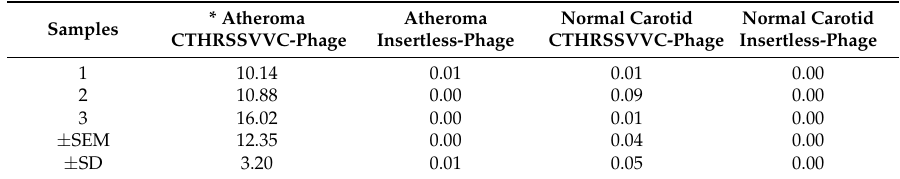
Table 3. Quantification of phage positivity for human atheroma